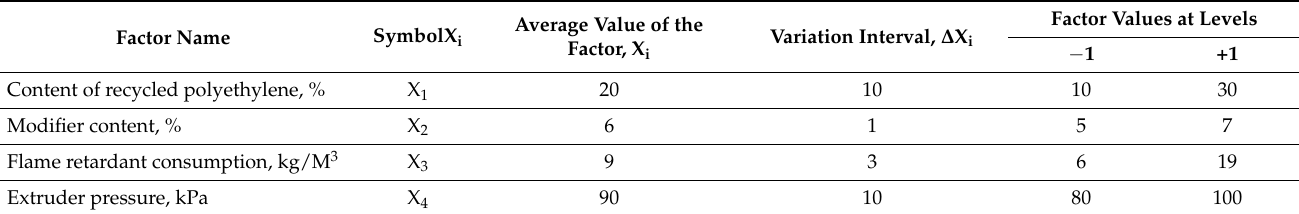
Table 1. Experimental